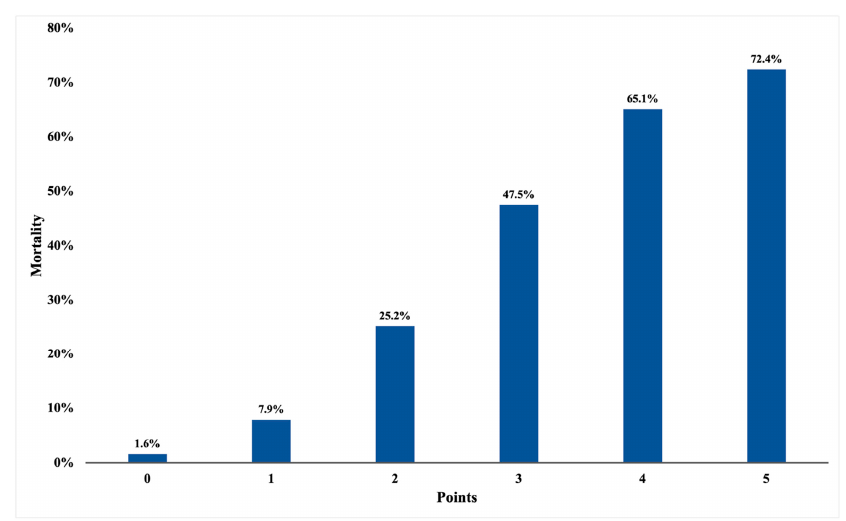
Figure 3. Observed in-hospital mortality rate based on GERtality score calculation. GERtality score comparison: The final ROC analysis of our patient collective showed an AUC (area under the curve) for the new GERtality score of 0.803 (CI (confidence interval) 0.799–0.807). The complex RISC-II score with its 15 variables showed an AUC of 0.879 (CI 0.876–0.883),